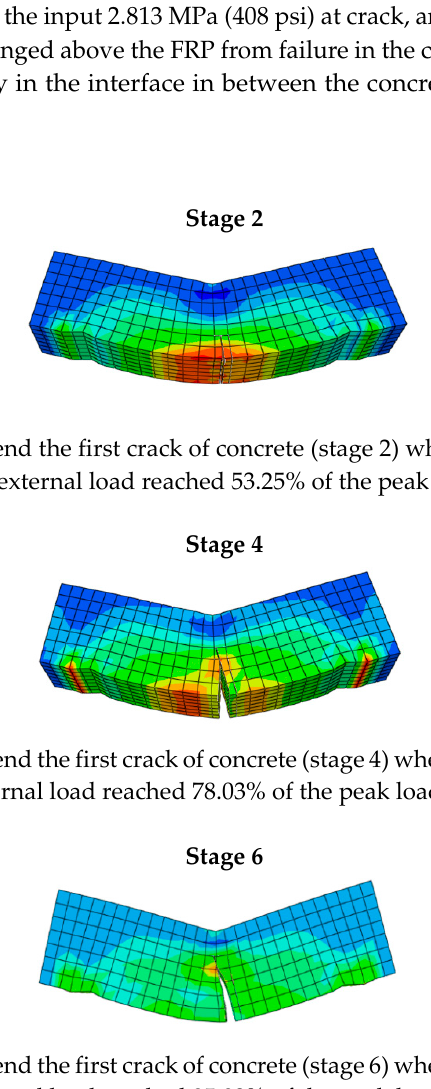
Figure 6. Concrete flexural crack, FRP rupture and delamination at experimental tests. Elarbi,